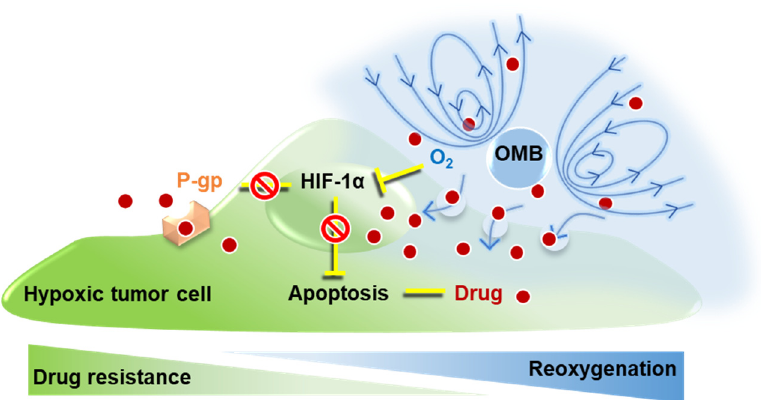
Figure 1. The mechanism of overcoming HDR by OMB treatment via promotion of drug uptake and reoxygenation for the in vitro cell study.